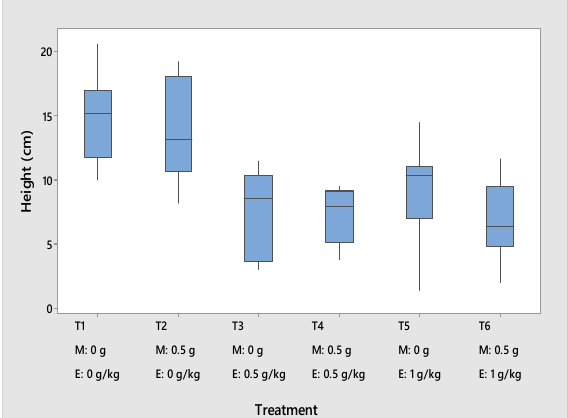
Figure 2 . Plant heights in the different treatments.